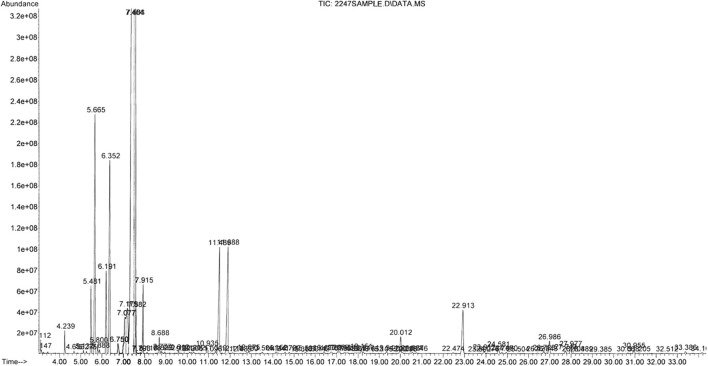
Gas chromatographic profile of the Melaleuca armillaris essential oil used (7).